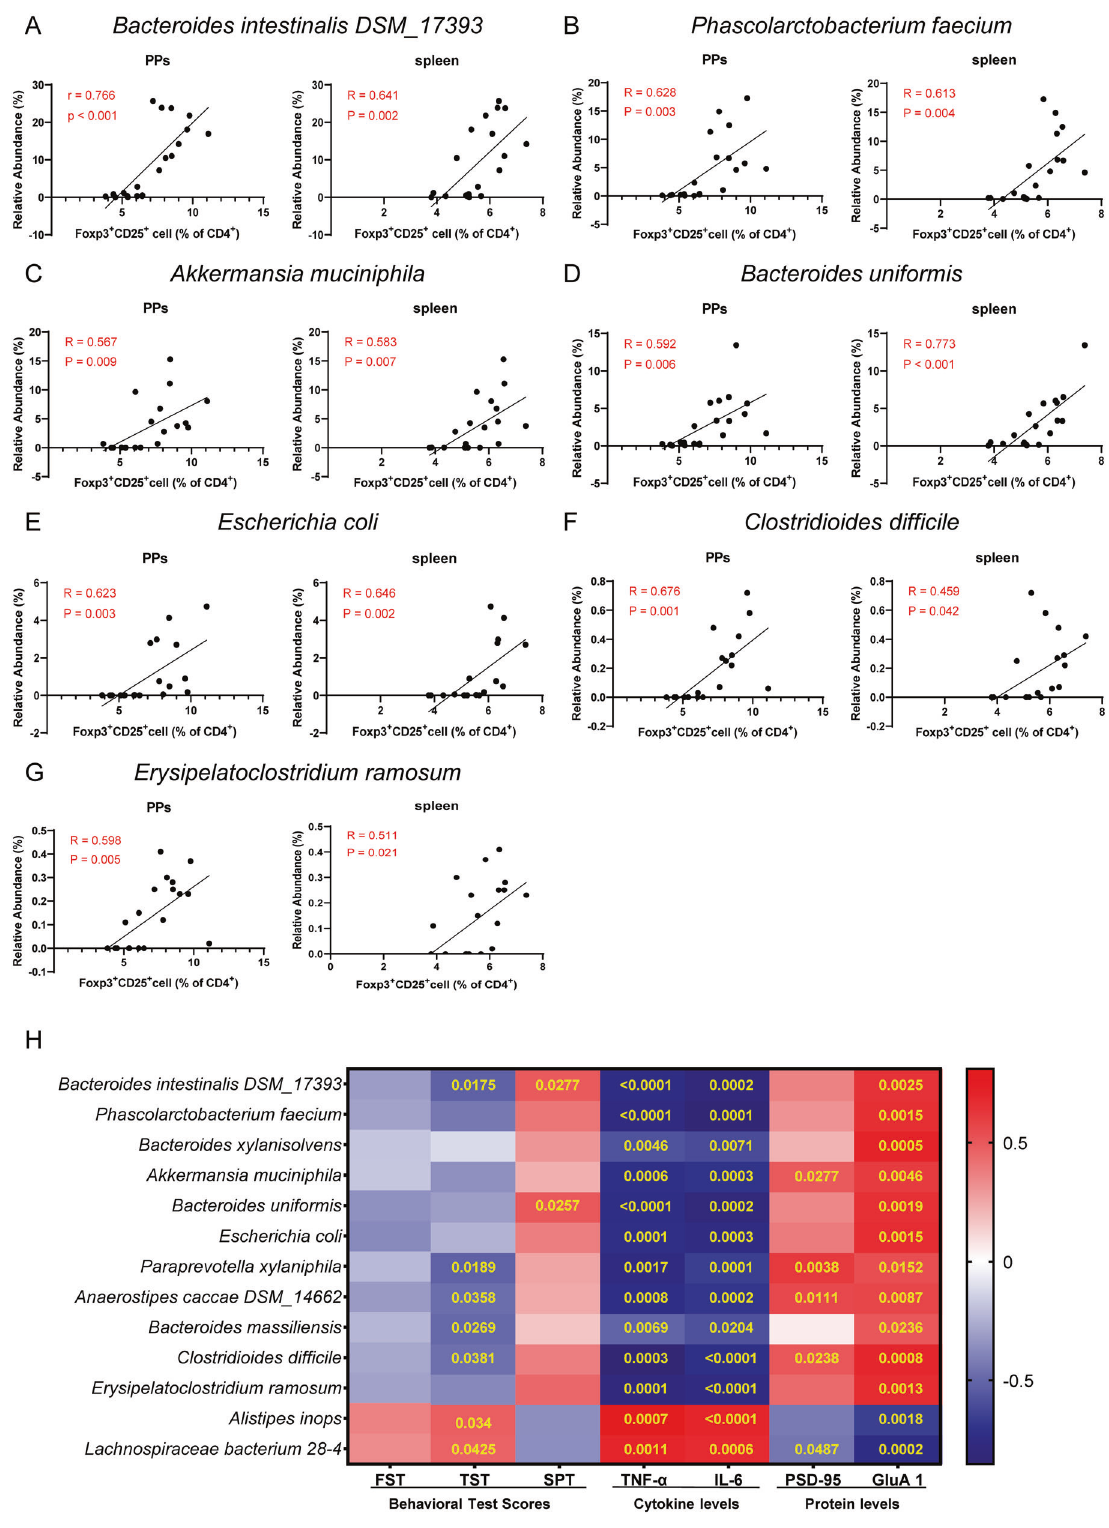
Fig. 5 Correlation of bacteria-species with Treg cell from PPs and spleen. A Bacteroides intestinalis DSM_17393 . B Phascolarctobacterium_faecium . C Akkermansia muciniphila . D Bacteroides uniformis . E Escherichia coli . F Clostridioides dif fi cile . G Erysipelatoclostridium ramosum . H The heat map displayed the correlation coef fi cient between bacterial abundance and the results of behavioral tests, cytokines, and western blot in the PFC. The yellow text in the center of each box represents the P